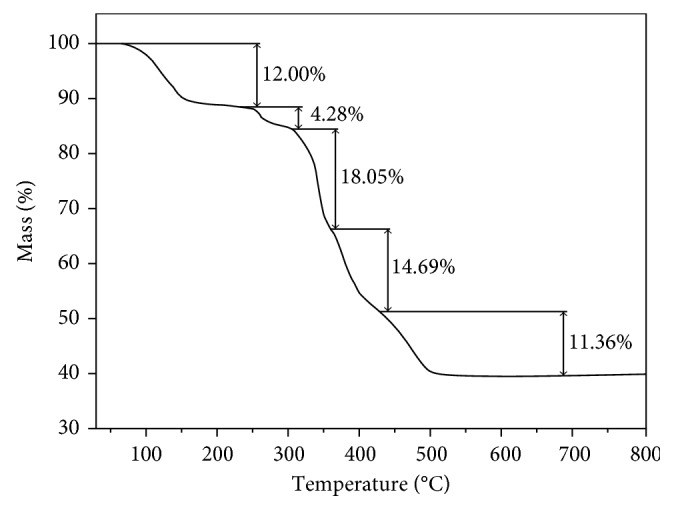
TG curve of the title complex.